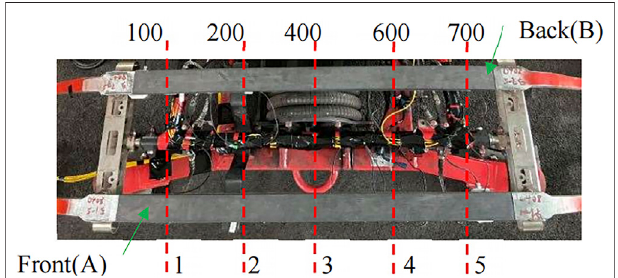
FIGURE 5 | Top view of the pantograph head.